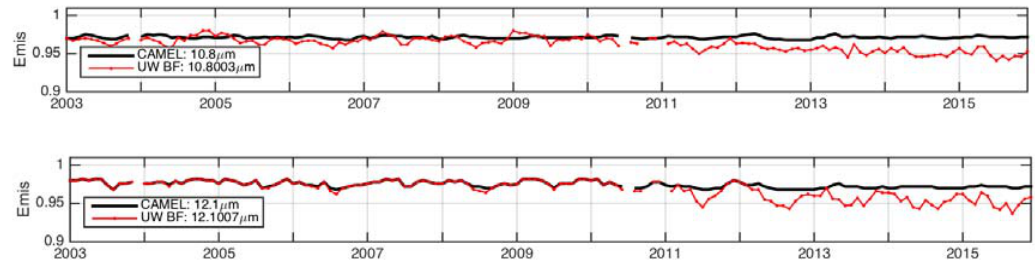
Figure 4. Time series of the Combined ASTER and MODIS Emissivity over Land (CAMEL) database and its input UW BF dataset at 10.8 µm ( top panel ) and 12.1 µm ( bottom panel ) is shown over the Atmospheric Radiation Measurement (ARM) Southern Great Plains (SGP) Cart Site. The CAMEL